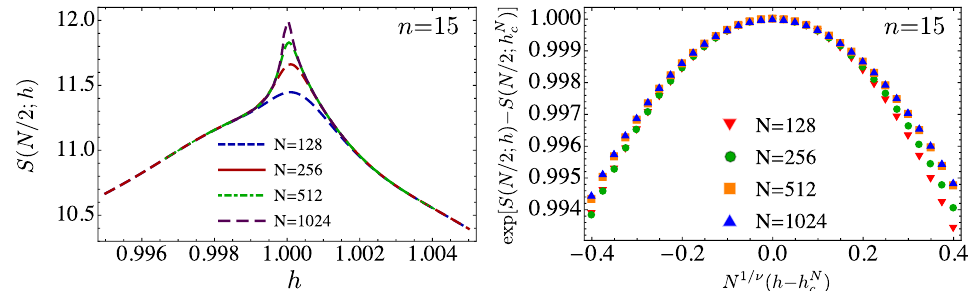
Figure 2. ( left ) Logarithmic divergence with the system size N of the half-chain entanglement entropy after n = 15 cycles of the drive h ( t ) = 1 + 1 sin ( π t ) . ( right ) Finite-size scaling with the critical 2 exponent ν = 1 of the Ising universality class of the data on the left panel close to h = h c